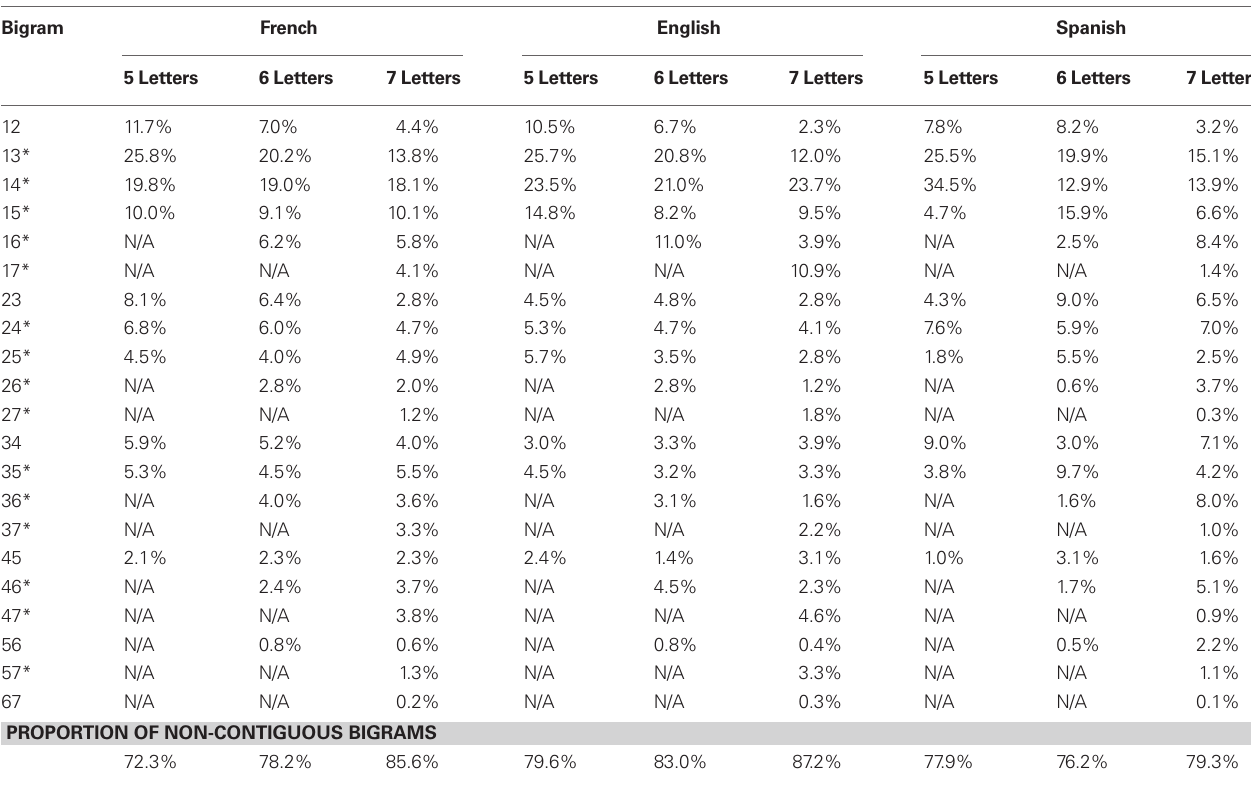
Table 2 | Proportion of letter positions in the most informative bigrams under realistic visibility.